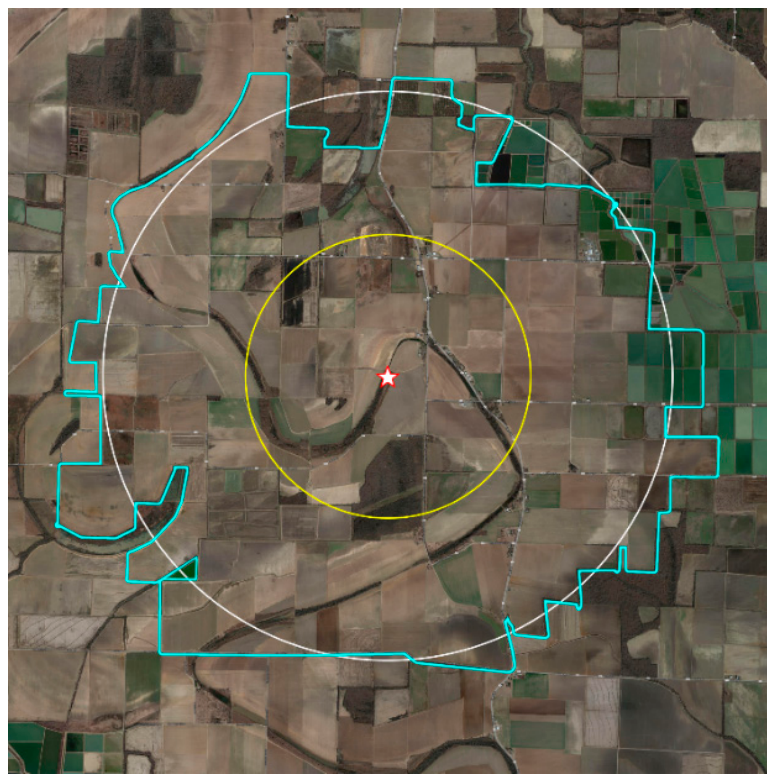
Figure 1. Aerial view of the High-Ag study site in Lonoke County, Arkansas. The star indicates the apiary location. The yellow circle indicates a one-mile radius from the beehives; the white circle indicates a two-mile radius from the hives; the blue line indicates the approximate area included in the survey. Landscape included the commercial production of soybeans, corn, rice, cotton, grain sorghum, and green beans, as well as commercial fish ponds, woodlands, grasslands, wetlands, and fallow fields. This site is representative of agricultural production land in this region (data: Google, Landsat/Copernicus, Maxar Technologies, US Geological Survey).